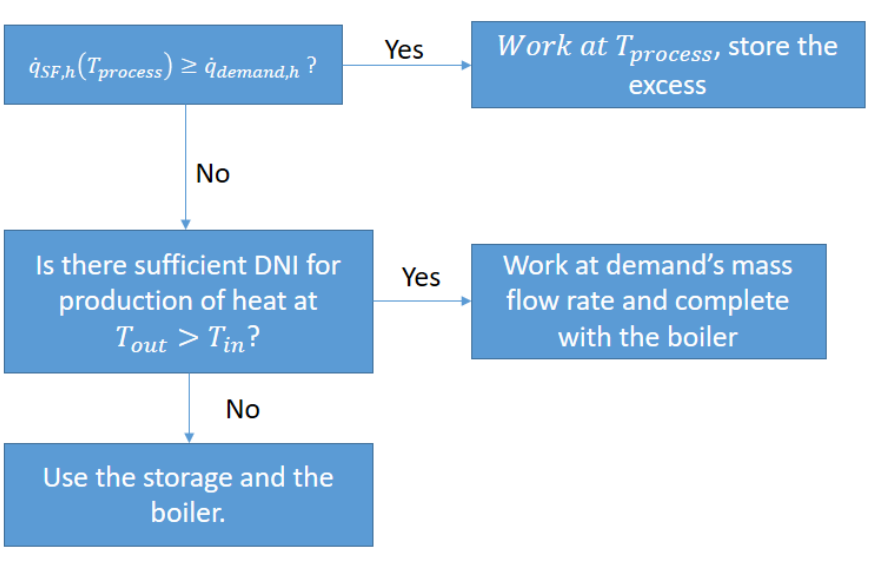
Figure 6. CA2 schematic approach.